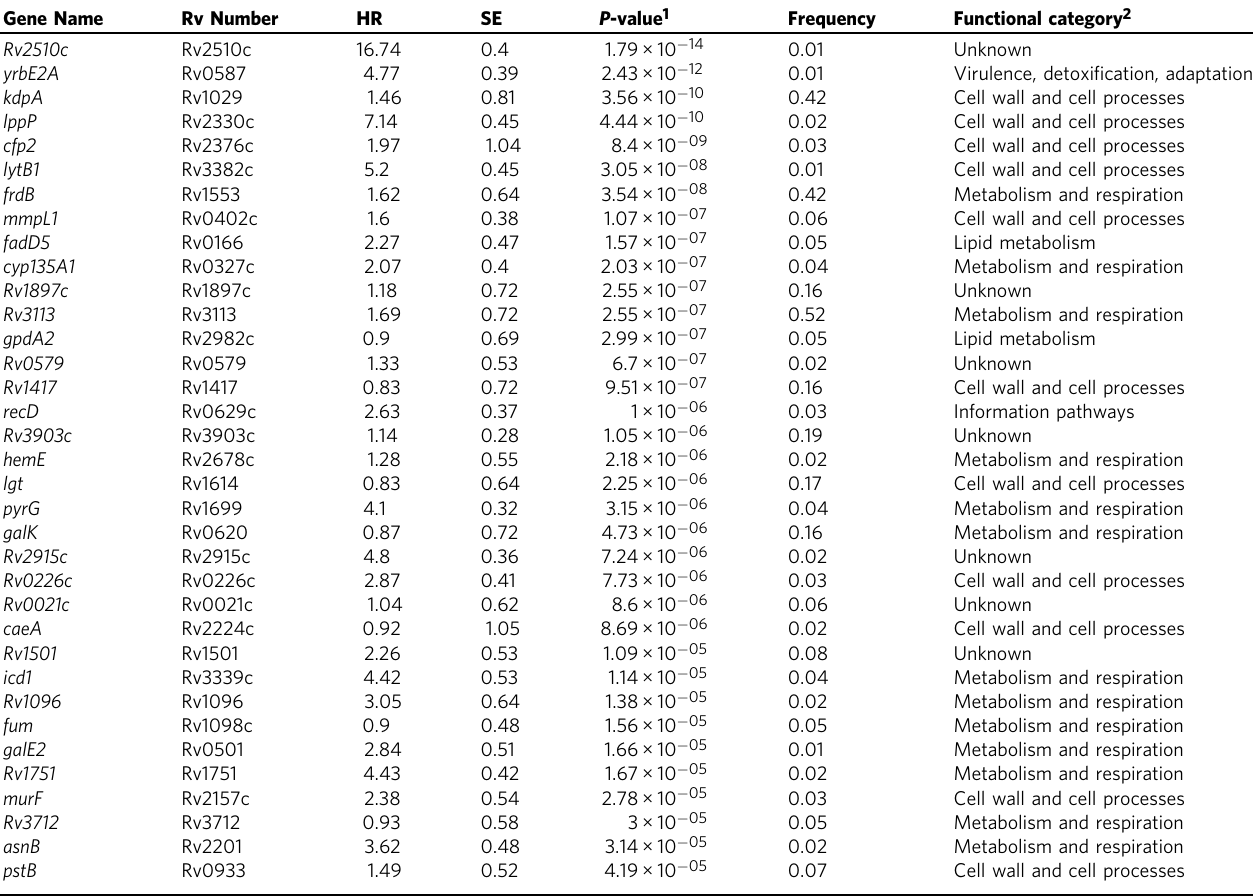
Table 3 Gene-based association analysis. Gene